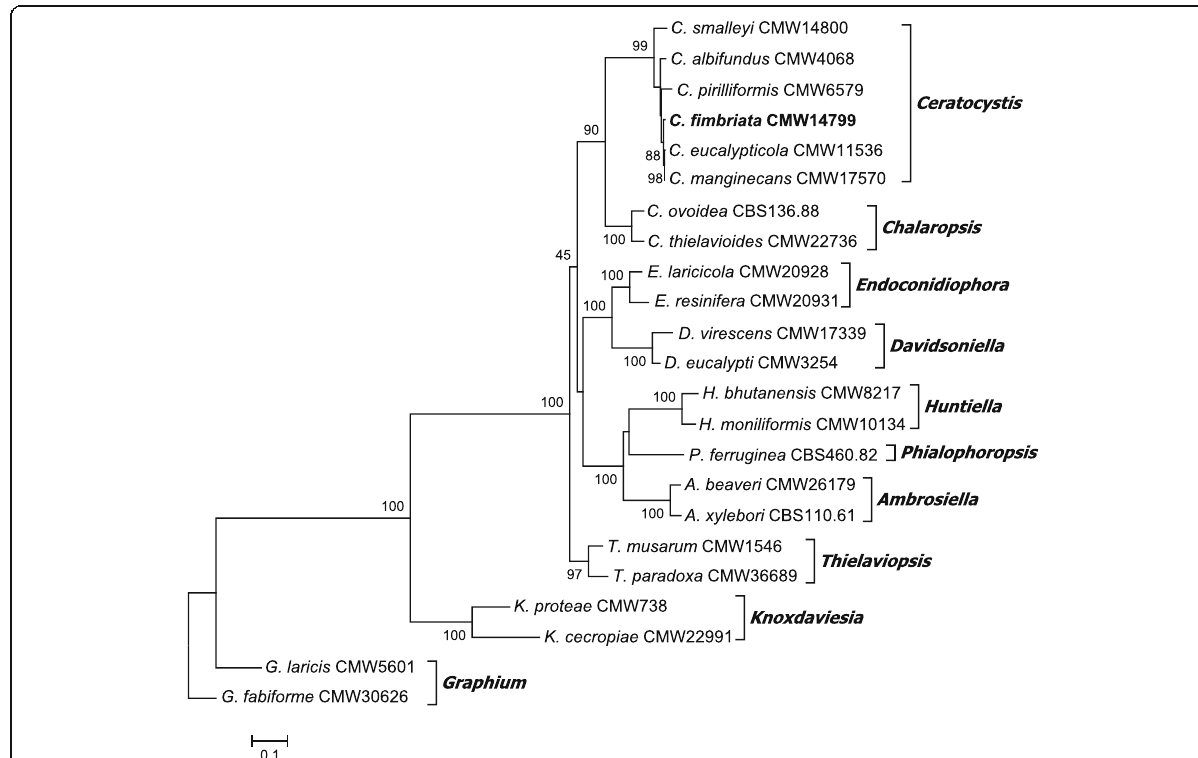
Fig. 1 Phylogenetic tree depicting the relationship between C. fimbriata (in bold) and related species and genera in the Microascales. The tree was constructed from 60S, LSU, MCM7 gene regions using RaxML. Bootstrap support (1000 replicates) are indicated at the